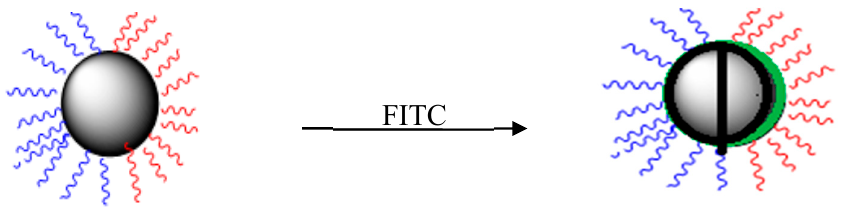
Figure 2. Fluorescence labeling schematic.